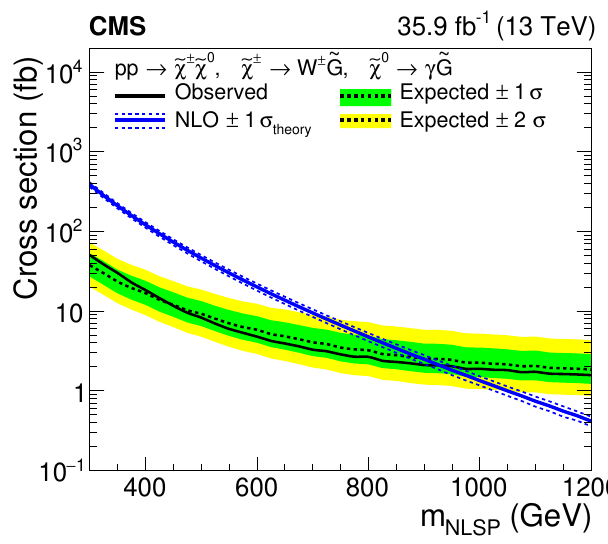
Figure 6 . The observed (solid line) and expected (dashed line) 95% CL upper limits on the production cross sections for the TChiWg simpli(cid:12)ed model, together with the NLO theoretical cross sections as a function of the NLSP mass. The inner (darker) band and outer (lighter) band around the expected upper limits indicate the regions containing 68 and 95%, respectively, of the distribution of limits expected under the background-only hypothesis. The dotted lines around the theoretical cross section gives the (cid:6) 1 standard deviation uncertainty in the cross